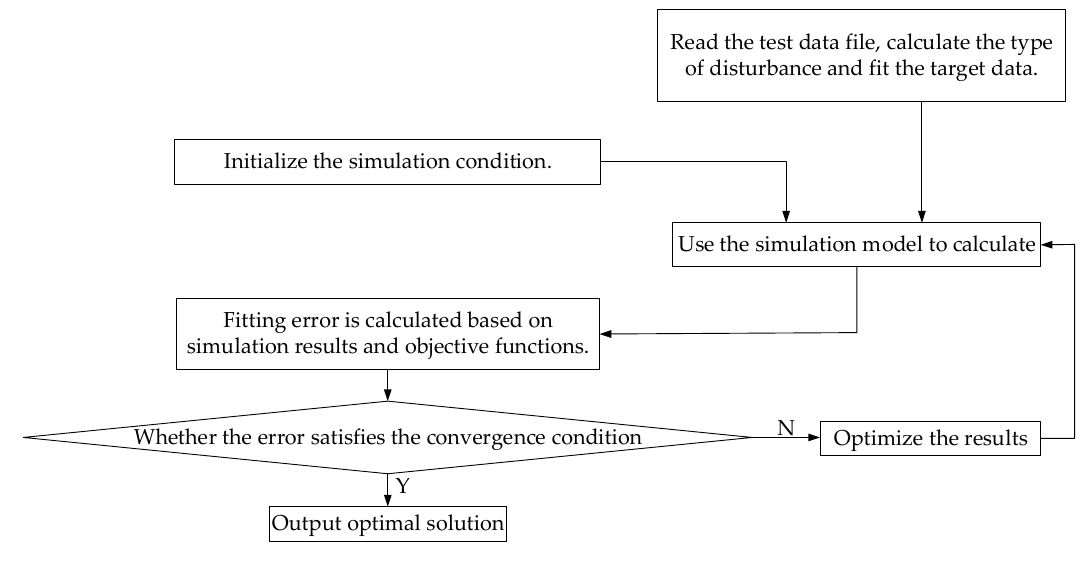
Figure 2. The steps of parameter identification.